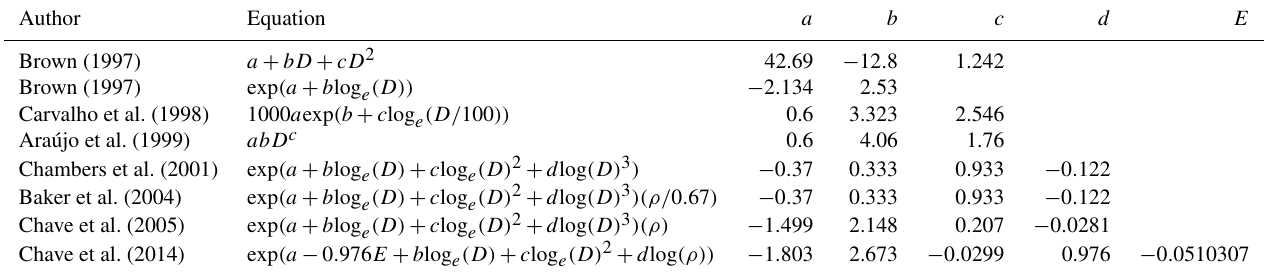
Table 2. Allometric equations used to calculate above-ground biomass, C v